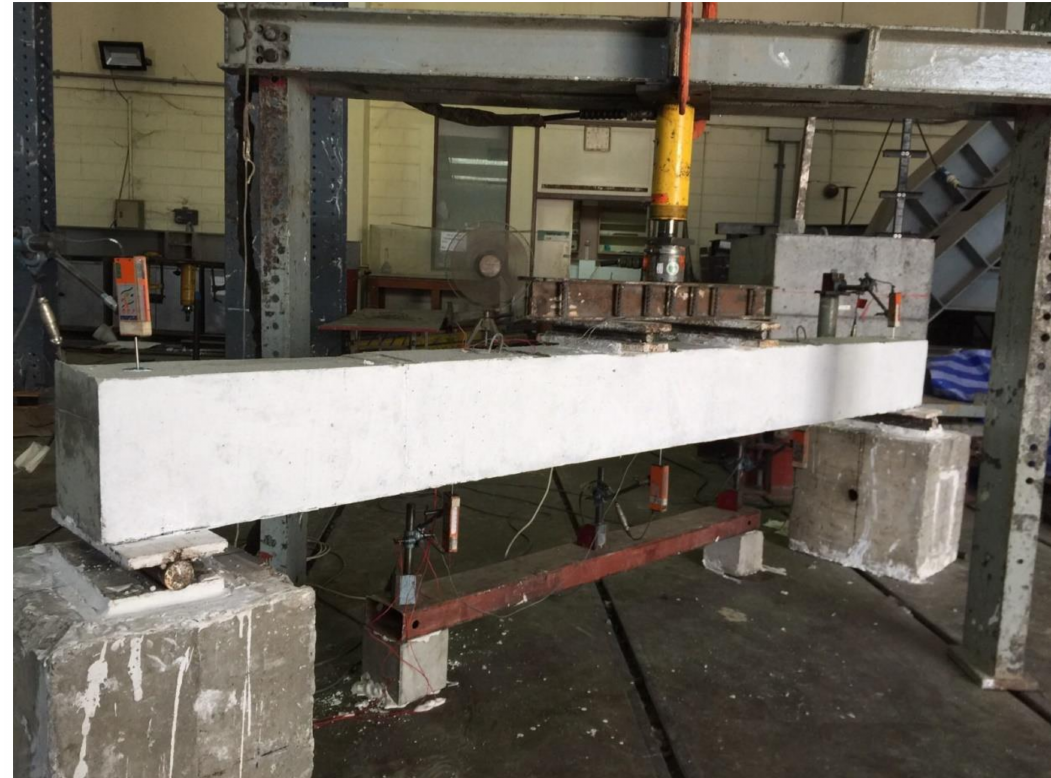
Figure 8. Actual test